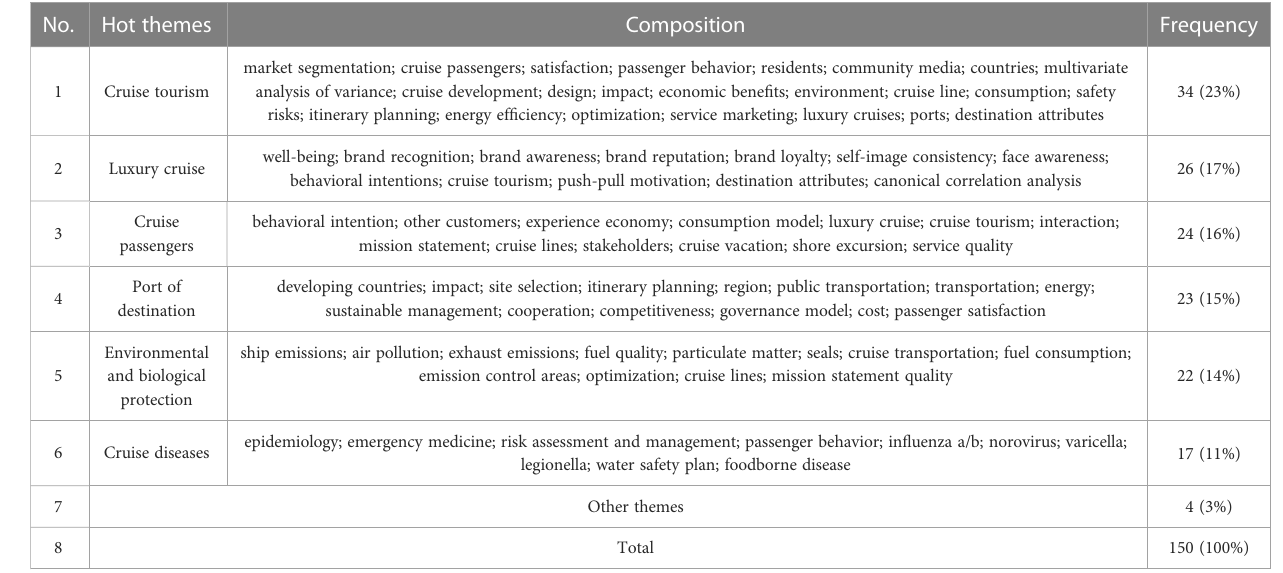
Figure 8 is a time zone map of the co-occurrence of keywords in cruise research from 2005 to 2019. Since there are fewer keywords